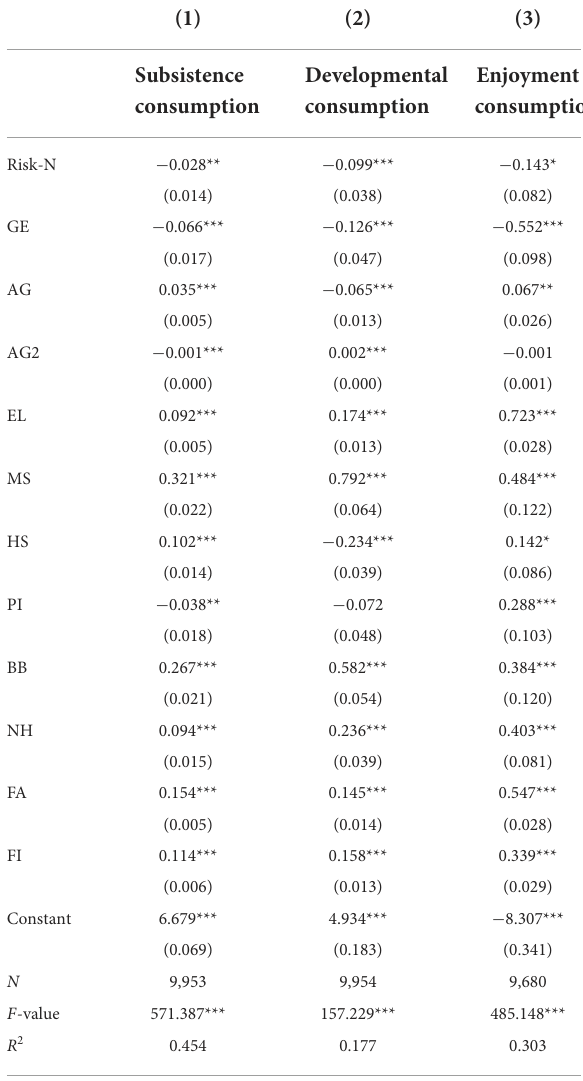
TABLE 13 The impact of risk aversion on household total consumption